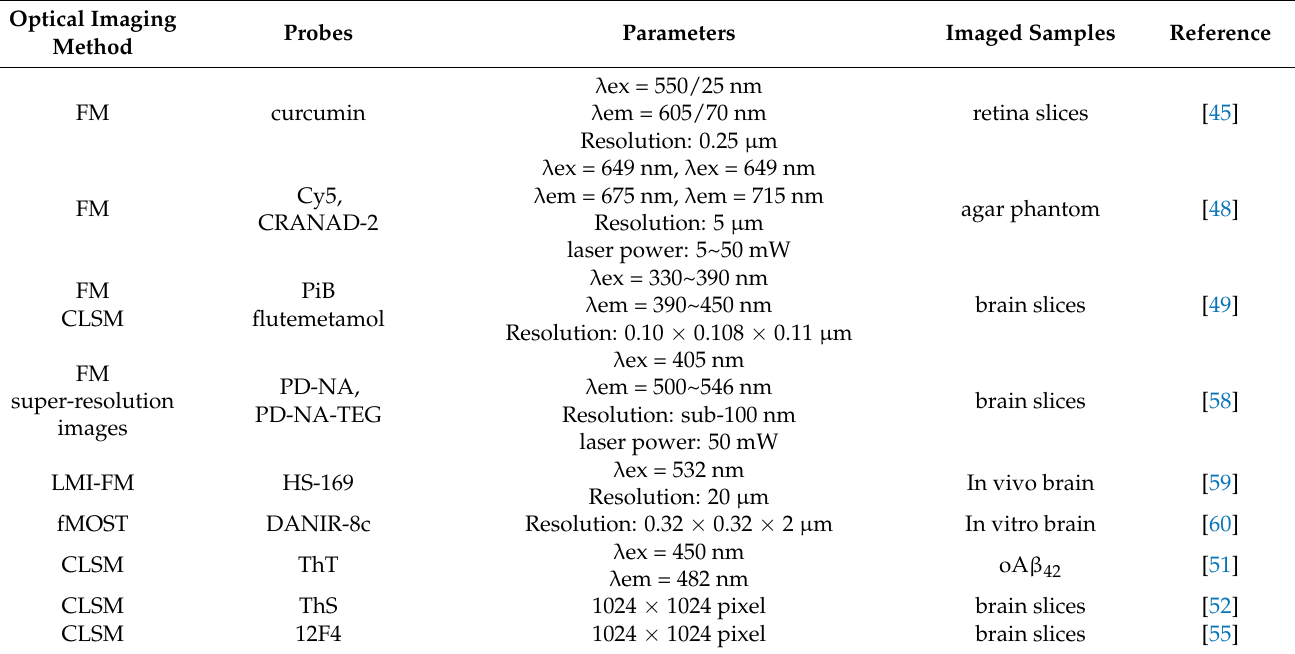
Table 1. Optical imaging in A β